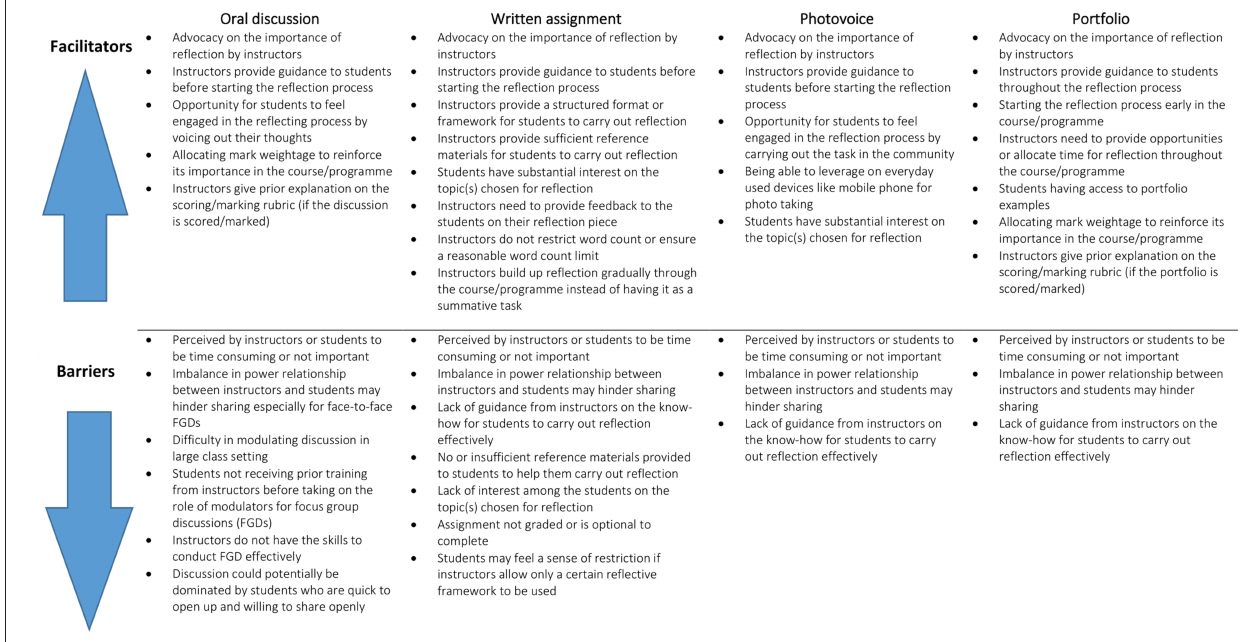
FIGURE 3 | Facilitators and barriers to performing deep self-reflection by students according to the different